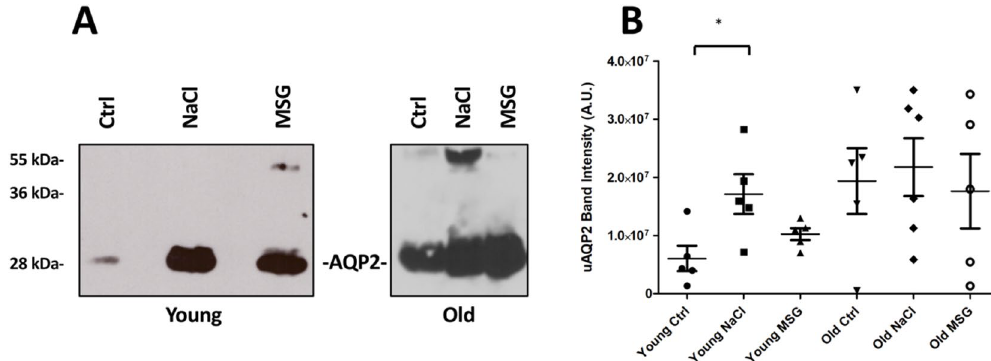
Figure 5. Analysis of AQP2 excretion in male mice urine. ( A ) Urine was collected from mice supplemented with water (control, Ctrl), NaCl (NaCl) or MSG (MSG) at two different end point time (young and old, 6 and 18 months respectively). A typical immunoblot with urinary samples is shown. Two bands can be seen, the top being glycosylated and the bottom non-glycosylated AQP2. ( B ) Summary of quantitative data (n = 6 in